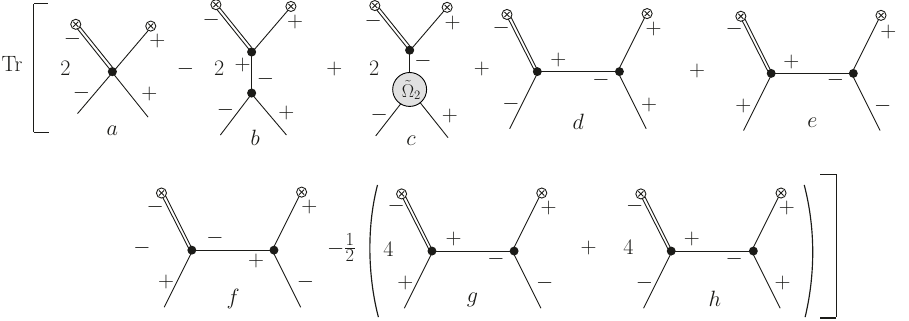
Figure 5 . Diagrams contributing to one-loop (+ − ) self energy diagram. For the discussion purpose, we show the diagrams as un-traced, i.e. the loop diagrams result in connecting the x-circles. The double line indicates a propagator.